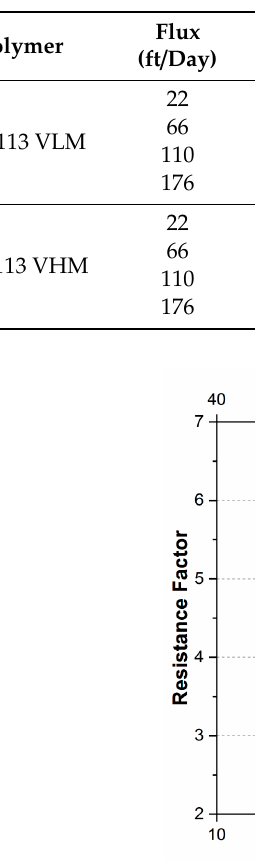
Table 6. Resistance Factor at Di ff erent Flux for AN 113 VLM and AN 113 VHM.